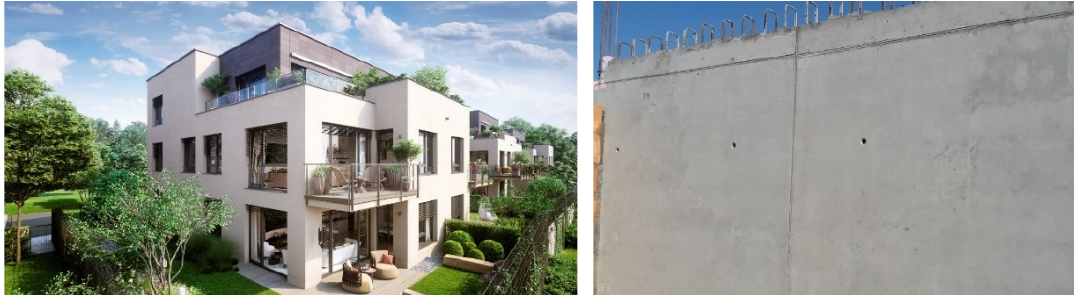
Figure 6. Residential project Devil’s Hill in Prague and first concrete